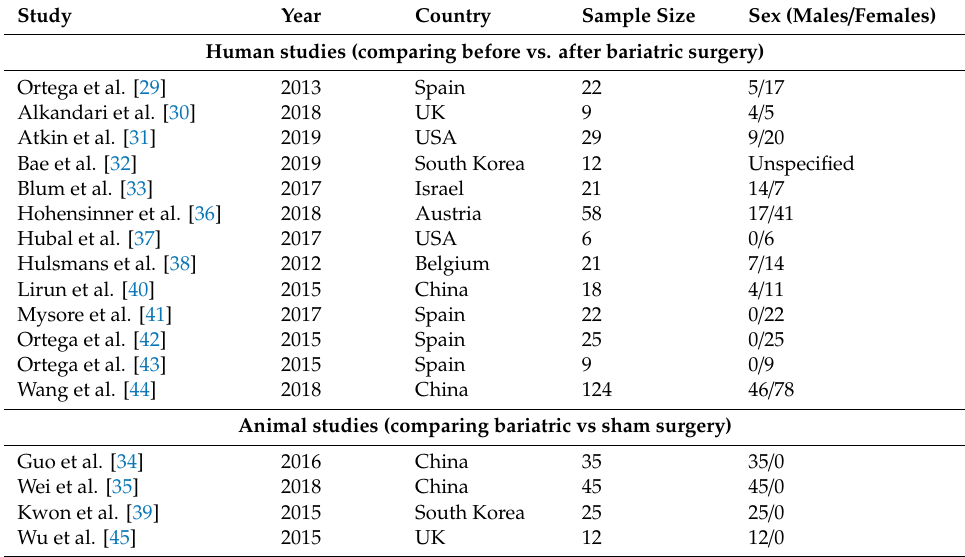
Table 1. The studies selected for meta-analysis.